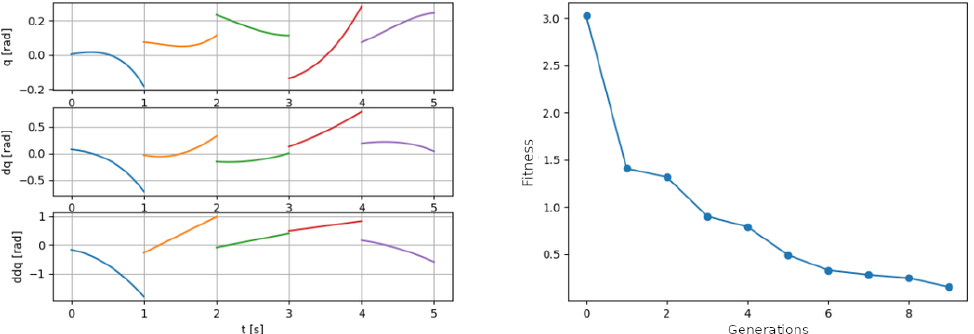
Figure 10. The behavior of the algorithm for the boundary condition set to 0.005. The best-achieved solution is visualized on the ( left ), and the fitness change through generations is on the ( right ).